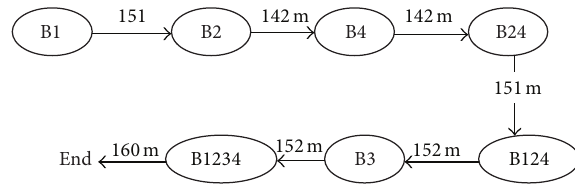
Figure 7: The filling sequence for the test case.